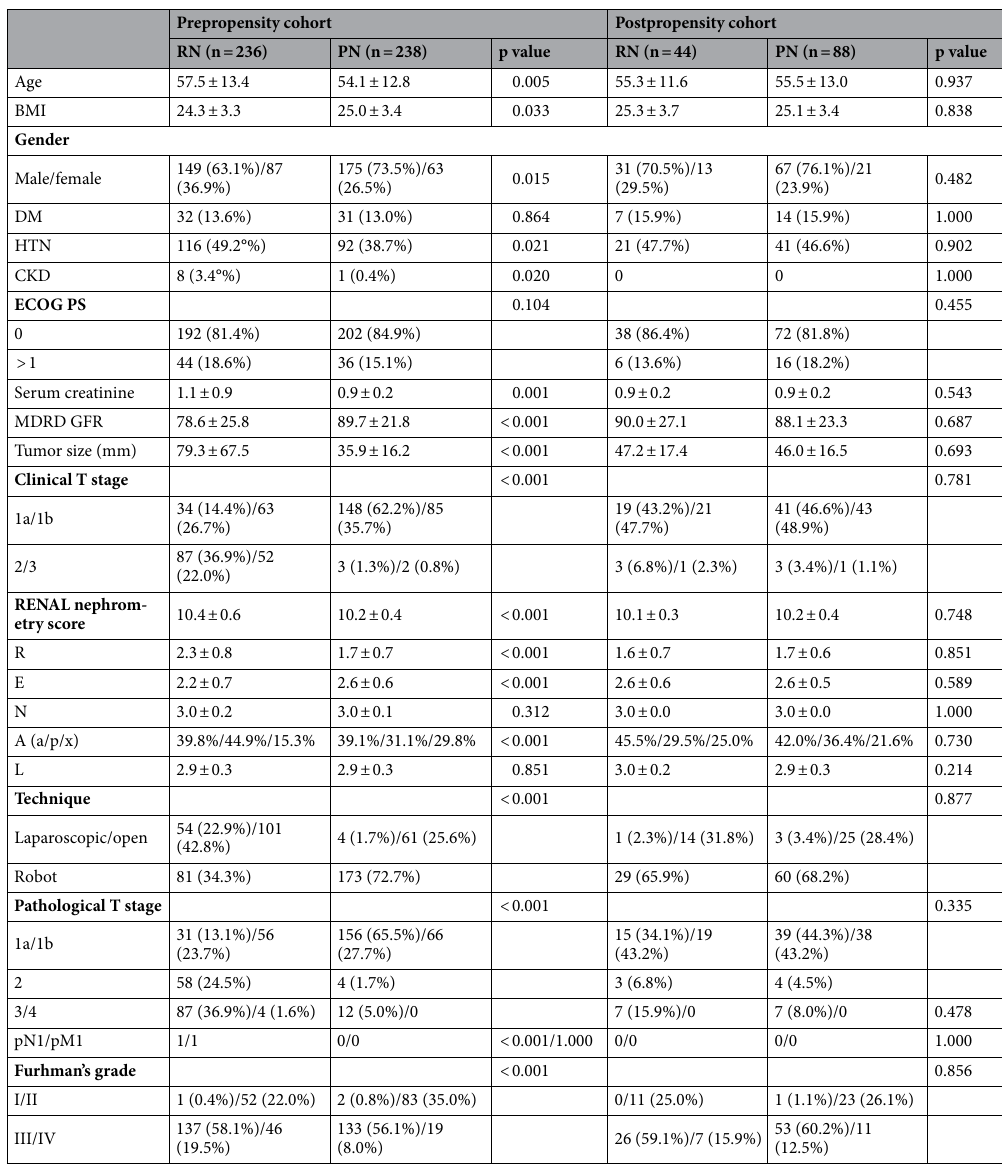
Table 1. Baseline characteristics of the patients. RN radical nephrectomy, PN partial nephrectomy, BMI body mass index, DM diabetes mellitus, HTN hypertension, ECOG Eastern cooperative oncology group performance status, MDRD modification of diet in renal disease, GFR estimated glomerular filtration rate, R radius (maximal diameter), E exophytic/endophytic, N nearness to collecting duct system/renal sinus, A anterior/posterior location, L location relative to the polar